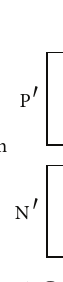
Figure 1: Confusion matrix.